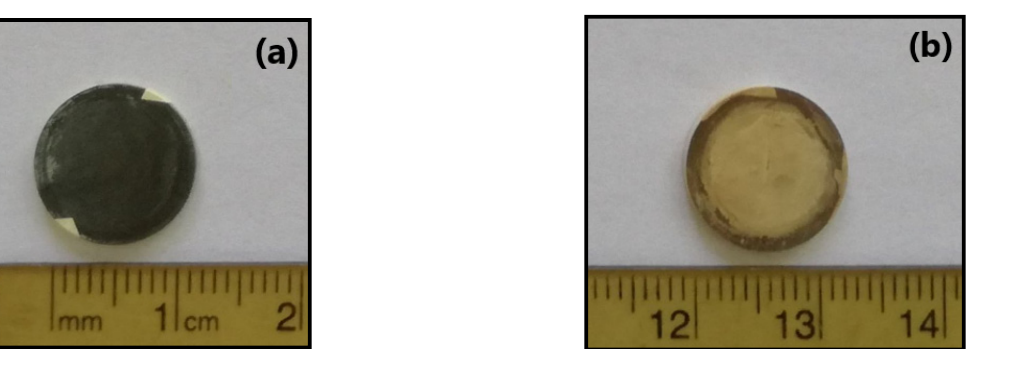
Figure 1. Pictures of the top surface of ( a ) U-LBL and ( b ) U-OP. UiO-66-NH 2 one-pot synthesis procedure (U-OP)